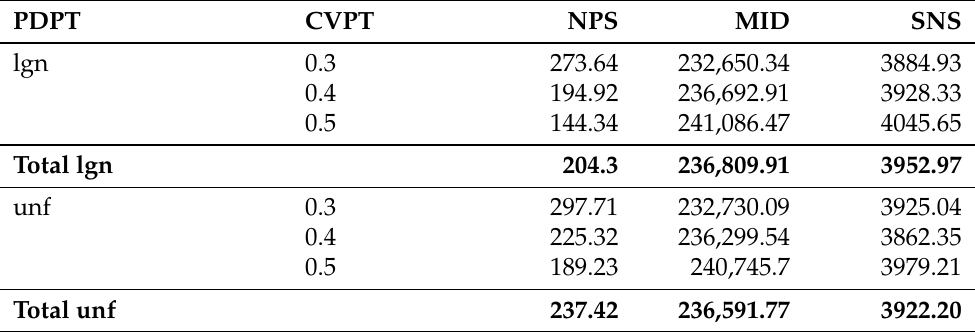
Table 12. Performance multi-objective metrics for the PDPT and